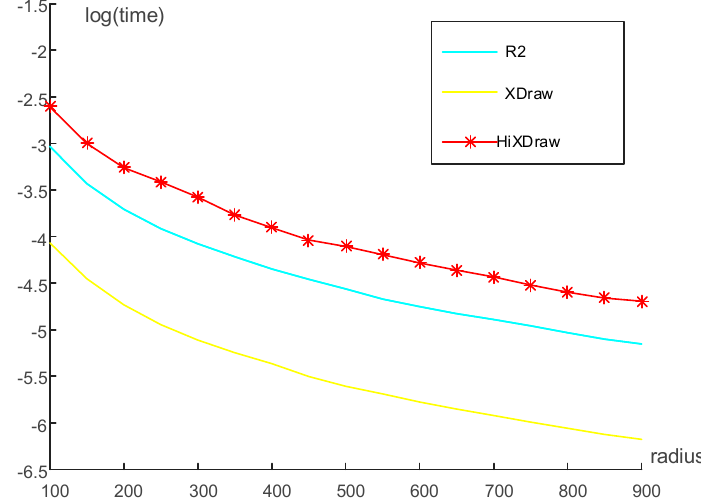
Figure 6. The number of error discrimination in logarithm. HiXDraw (red) performs better than R2 (cyan) and much better than the original XDraw (yellow) concerning accuracy.